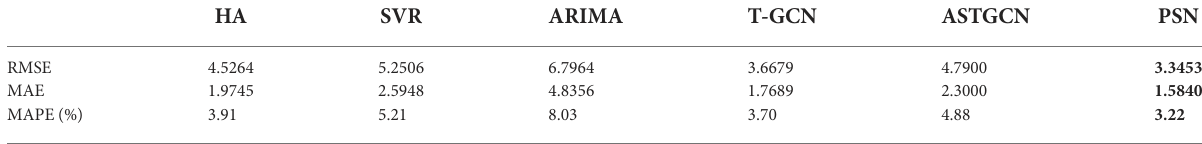
TABLE 1 PEMS04-30 min